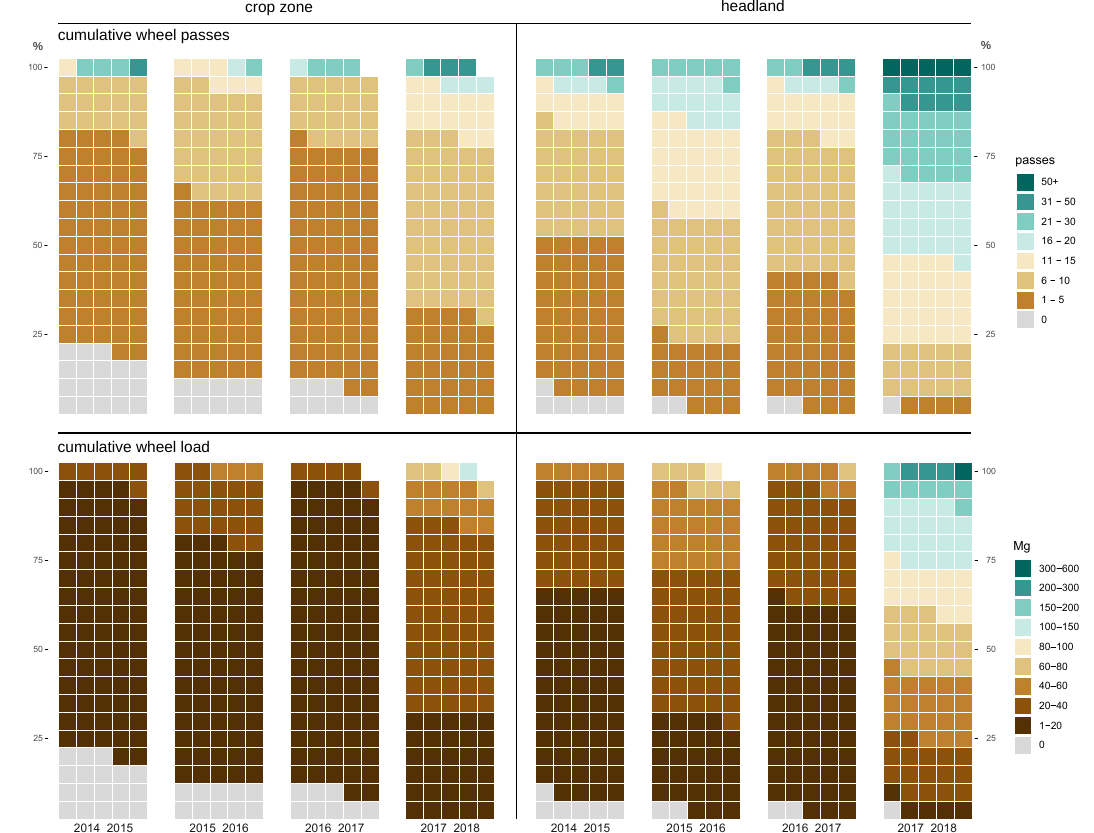
Figure 3. The cumulative wheel loads and wheel passes during the single seasons of winter wheat (2014–2015, 2016–2017), silage maize (2015–2016) and sugar beet (2017–2018). The classes are chosen broadly at the extremes, as the area percentages in the higher ranges are very small and would otherwise not be presentable. Due to rounding, 2016–2018 is missing 1% in the crop zone and 2015–2016 in the headland. Data and script for the creation of the figure is attached in the Supplementary Materials (Table